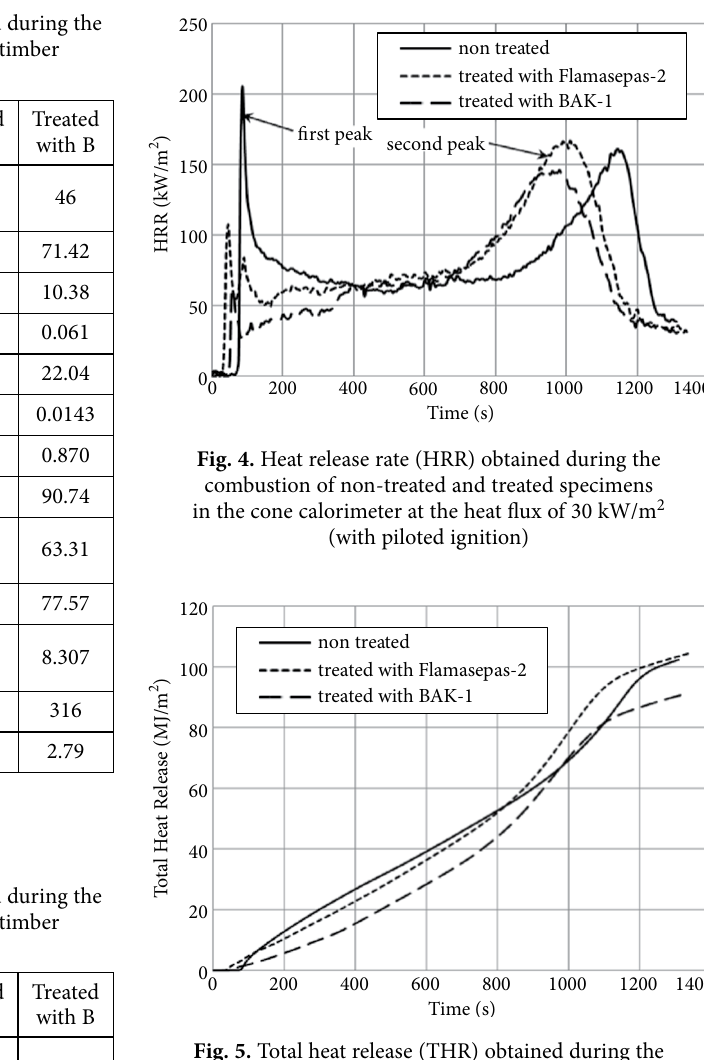
Fig. 5. Total heat release (THR) obtained during the